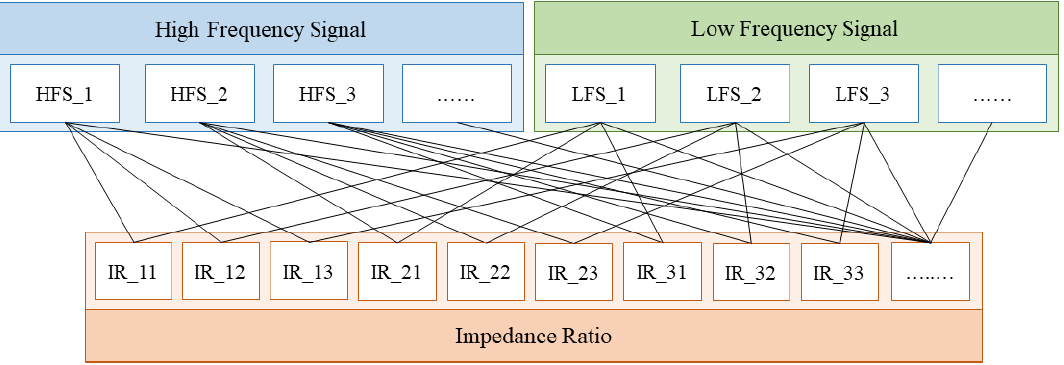
Figure 4. Diagram of the data augmentation.